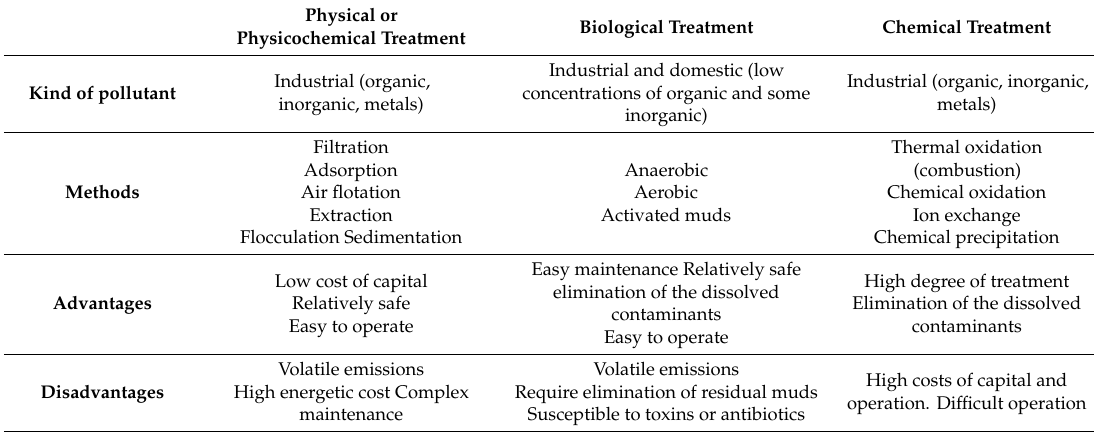
Table 1. Advantages and disadvantages of the di ff erent kinds of water